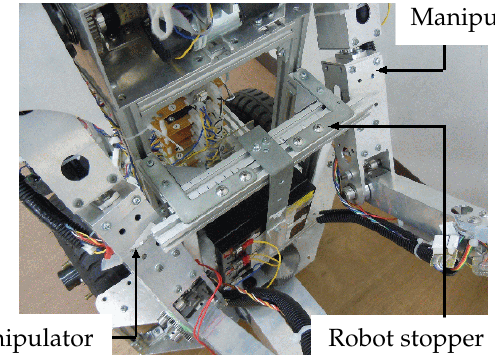
Figure 8. Locations of manipulators for lifting the front wheels of the cart.